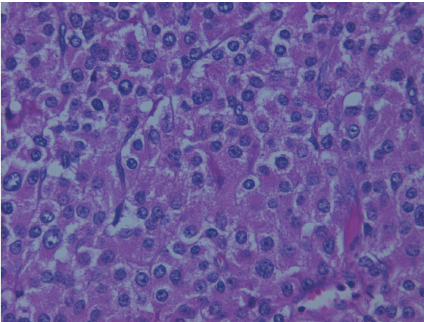
Figure 2: Microscopic features of the adrenocortical neoplasm with abundant eosinophilic and granular cytoplasm (H.E. ×